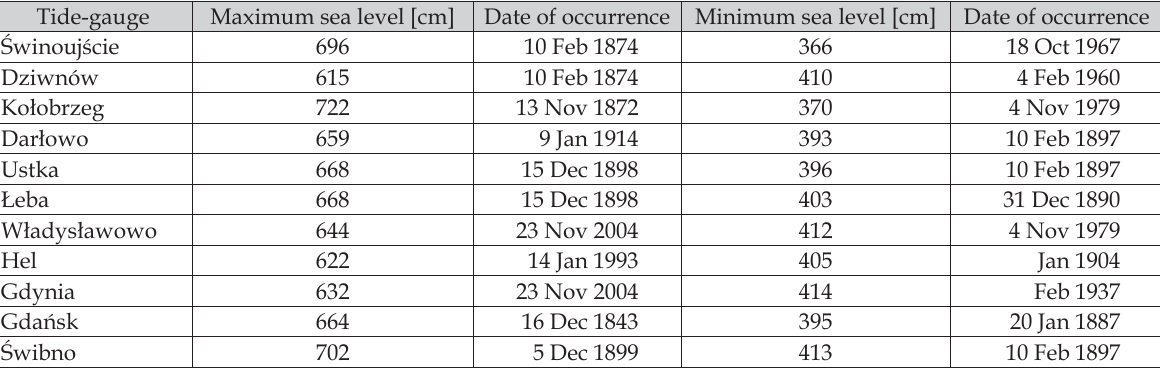
Table 1. Extreme sea levels [cm] along the Polish coast (Wiśniewski, Wolski 2009) (tide gauge zero = 500 cm